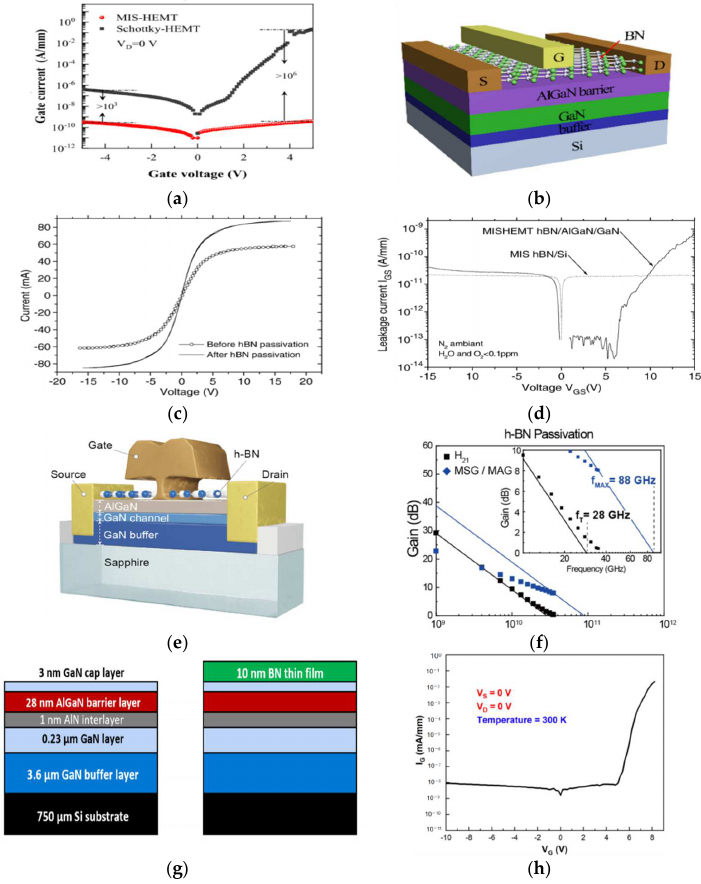
Figure 8. ( a ) Schematic structure of MIS-HEMT with BN dielectric. ( b ) The gate leakages current as a function of gate voltage, while the drain voltages were kept at 0 V [51] . ( c ) I–V measurement be- tween two ohmic contacts with a spacing of 5 µm in an AlGaN/GaN structure, before and after passivation with a thick 25 nm hBN thin film. ( d ) I GS –V GS characteristic of Au/Ni/h-BN (25 nm)/Al- GaN/GaN/Al 2 O 3 MIS-HEMT structure with LG = 2 µm and W = 100 µm [52]. ( e ) Schematic cross- section of the fabricated AlGaN/GaN HEMT. ( f ) Transfer characteristics, drain current, and trans- conductance as a function of gate bias [53]. ( g ) The structure of the BN/AlGaN/GaN HEMTs. ( h ) I G – V G curve of the ECR-MPCVD-BN/AlGaN/GaN MIS-HEMTs [54].